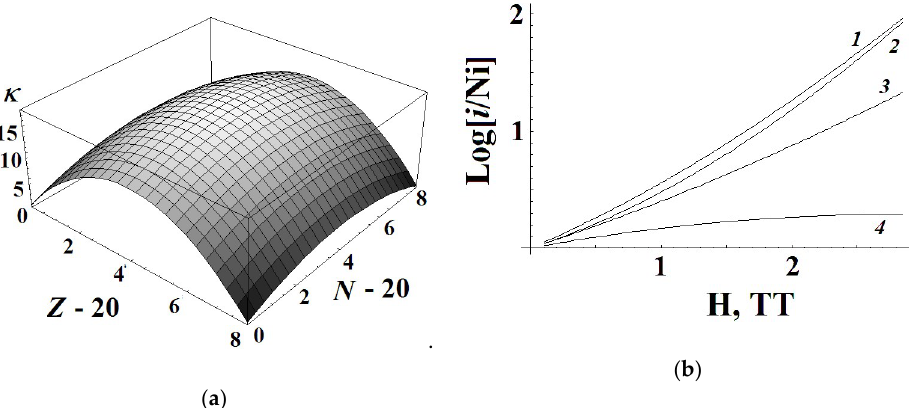
Figure 1. Magnetic e ff ects for nuclei in the iron region: ( a ) Dependence on the number of protons and neutrons of the magnetic susceptibility for nuclei with filled 1 f 7/2 shell. The minimum values = 0 correspond to double magic nuclei at Z (& N ) = 20 or 28, the maximum value κ max ≈ 17.51 κ magic for the antimagic nucleus 48 Cr at Z = N = 24; ( b ) Magnetic field dependence of the yield ratio [ i /Ni ] (see text) for 56 Ni and 44 Ti—2, 48 Cr—1, 52 Fe—3, 60 Zn—4, at kT = 0.5